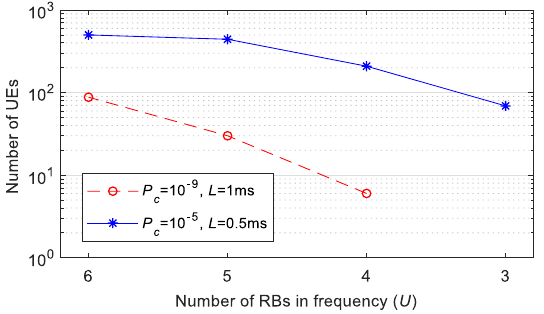
Figure 6. Number of UEs supported for a given L and P rel = 1 − P c with P sc = 0 as a function of the number U of available RBs per T slot ( λ = 0.1 packets).